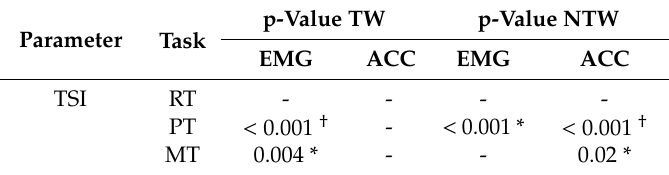
Table 3. Results of the statistical